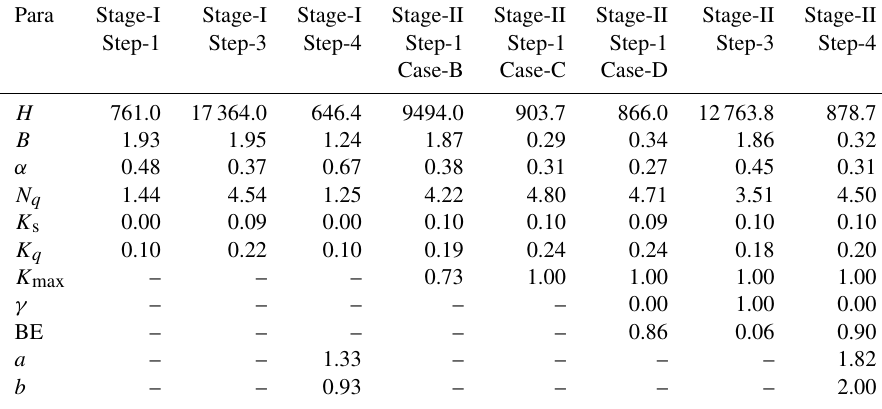
Table C1. This table provides calibrated parameters of the actual and modified HYMOD